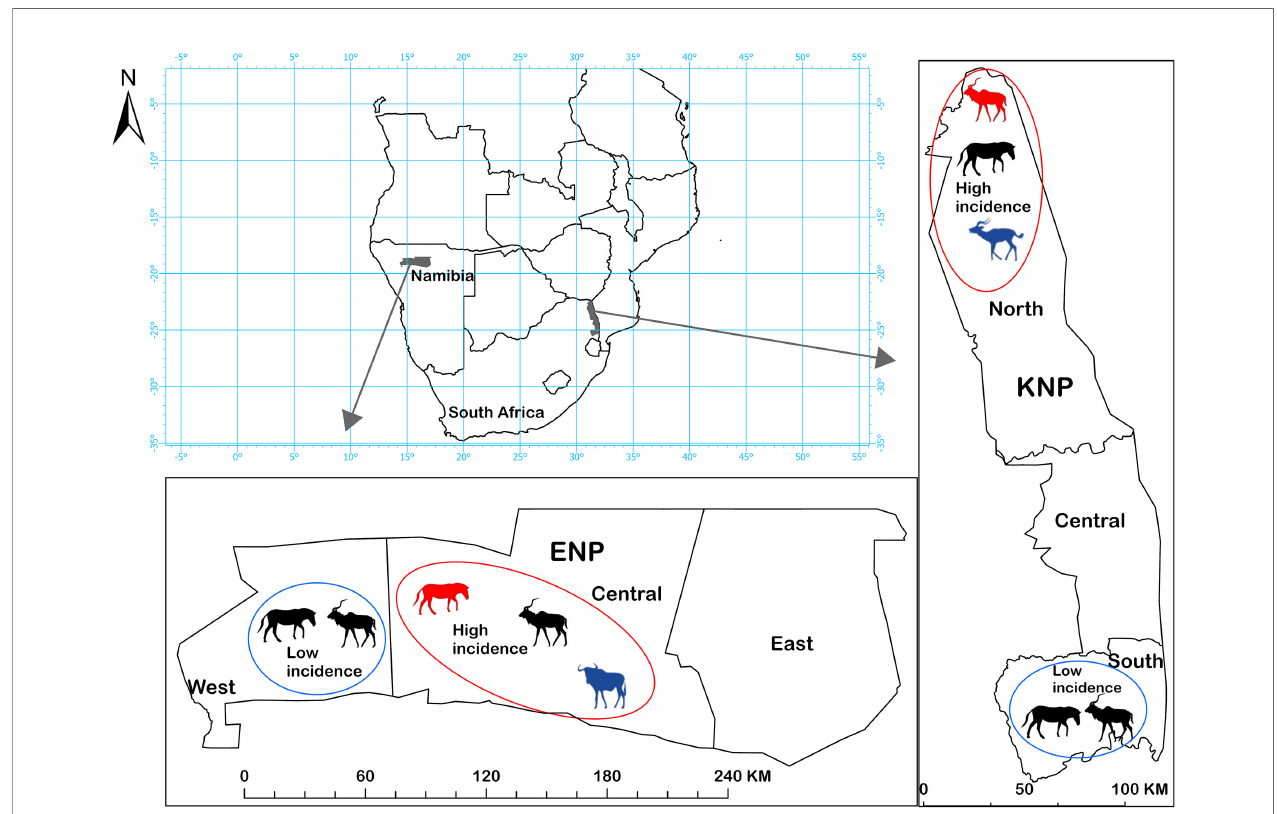
FIGURE 1 | Etosha National Park (ENP) and Kruger National Park (KNP) in southern Africa, showing the study areas where anthrax outbreaks occur with high (red circles) or low (blue circles) incidence. Host species sampled for this study in different areas are shown with animal silhouettes. Kudu ( Tragelaphus strepsiceros ) and zebra ( Equus quagga ) were sampled in all four areas. Secondary host species were sampled in high incidence areas of each park: impala ( Aepyceros melampus ) in KNP, and wildebeest ( Connochaetes taurinus ) in ENP. The primary anthrax host species in a high incidence area is shown in red and the secondary host species in blue, otherwise, silhouettes are black. Assignment of areas as high or low incidence was based on anthrax mortality patterns observed in each park, and where anthrax occurs most commonly or least commonly,